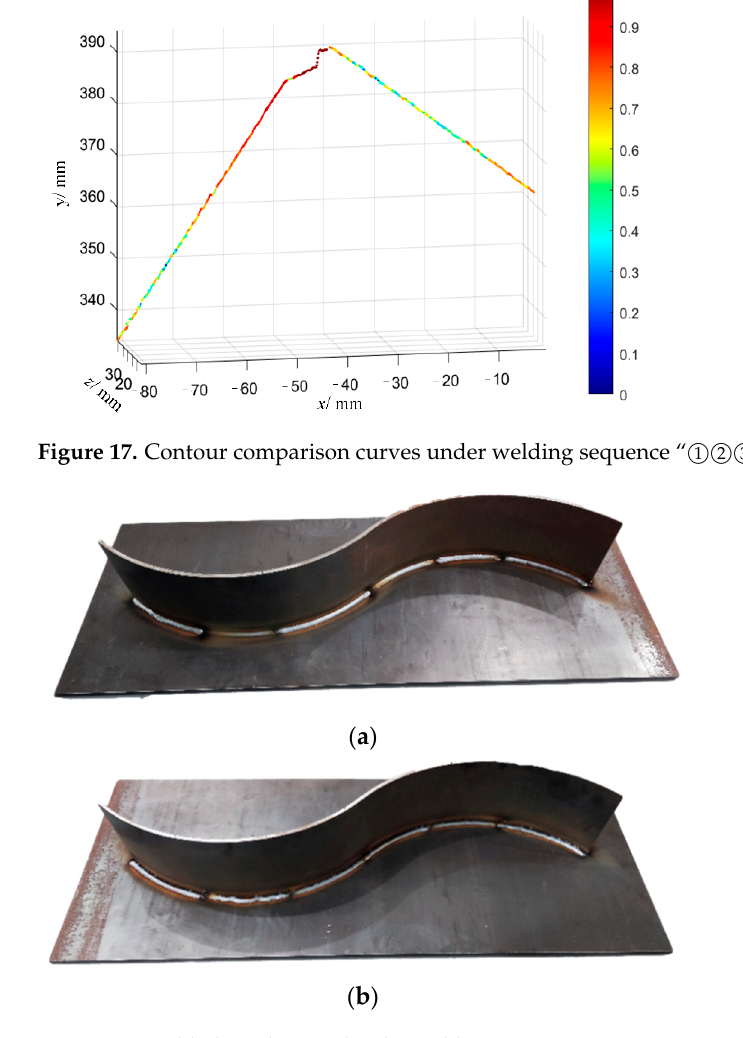
Figure 18. Welded product under the welding sequence “ ②④③⑤①⑥ ”: ( a ) front view; ( b ) reverse view.